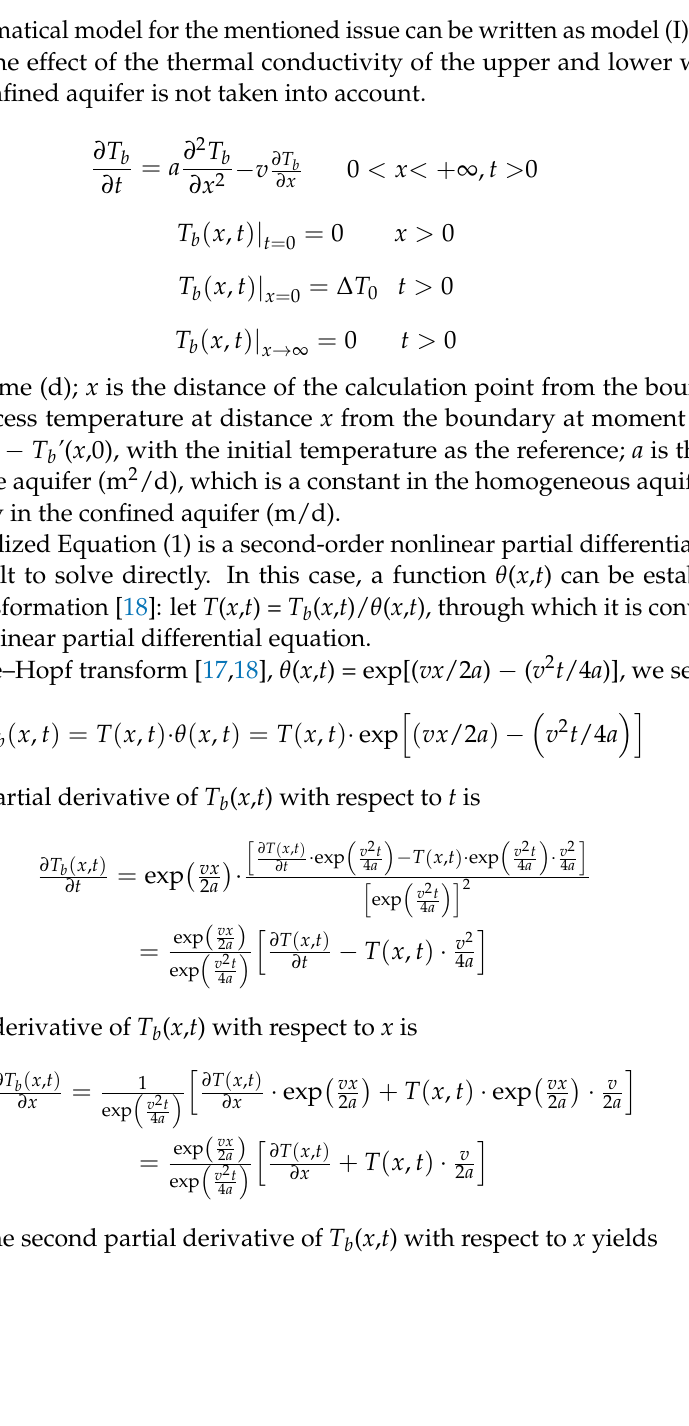
Figure 3. Schematic map of the effect of temperature variation in the river channel on the aquifer.